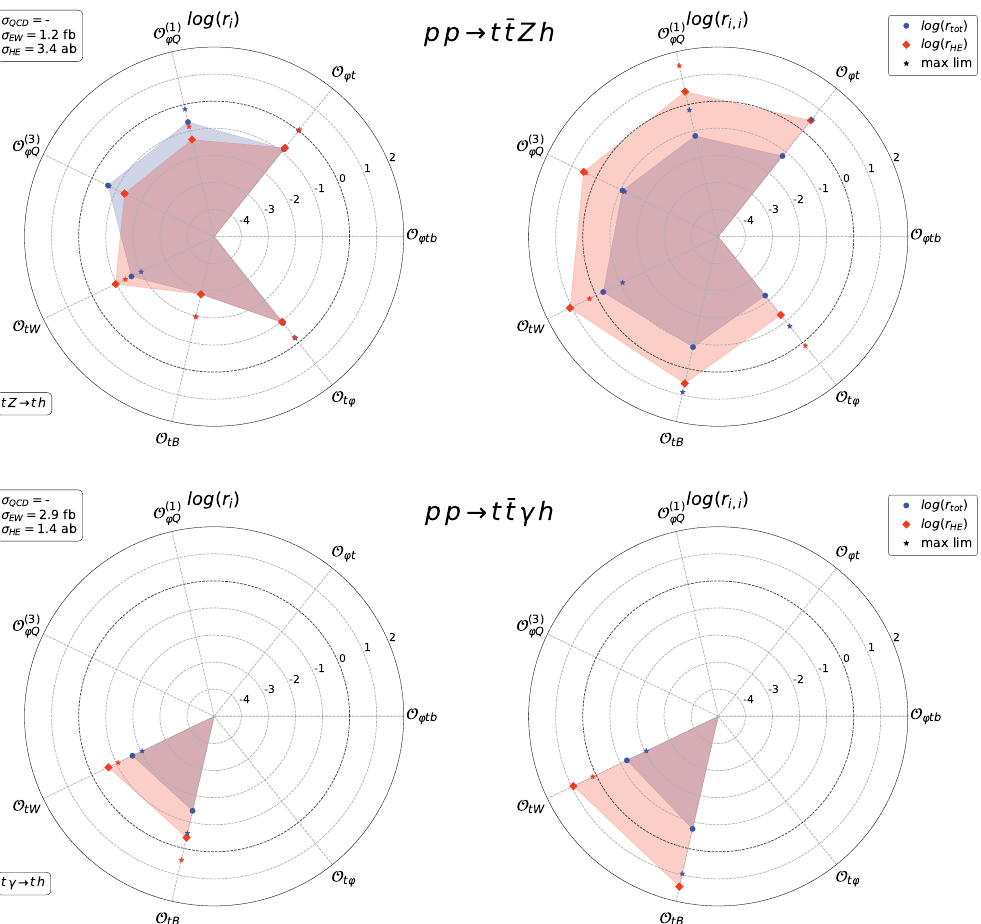
Figure 37. Radar plot for the p p (cid:12)gure 7 and section 4.1.2 of the main text for a detailed